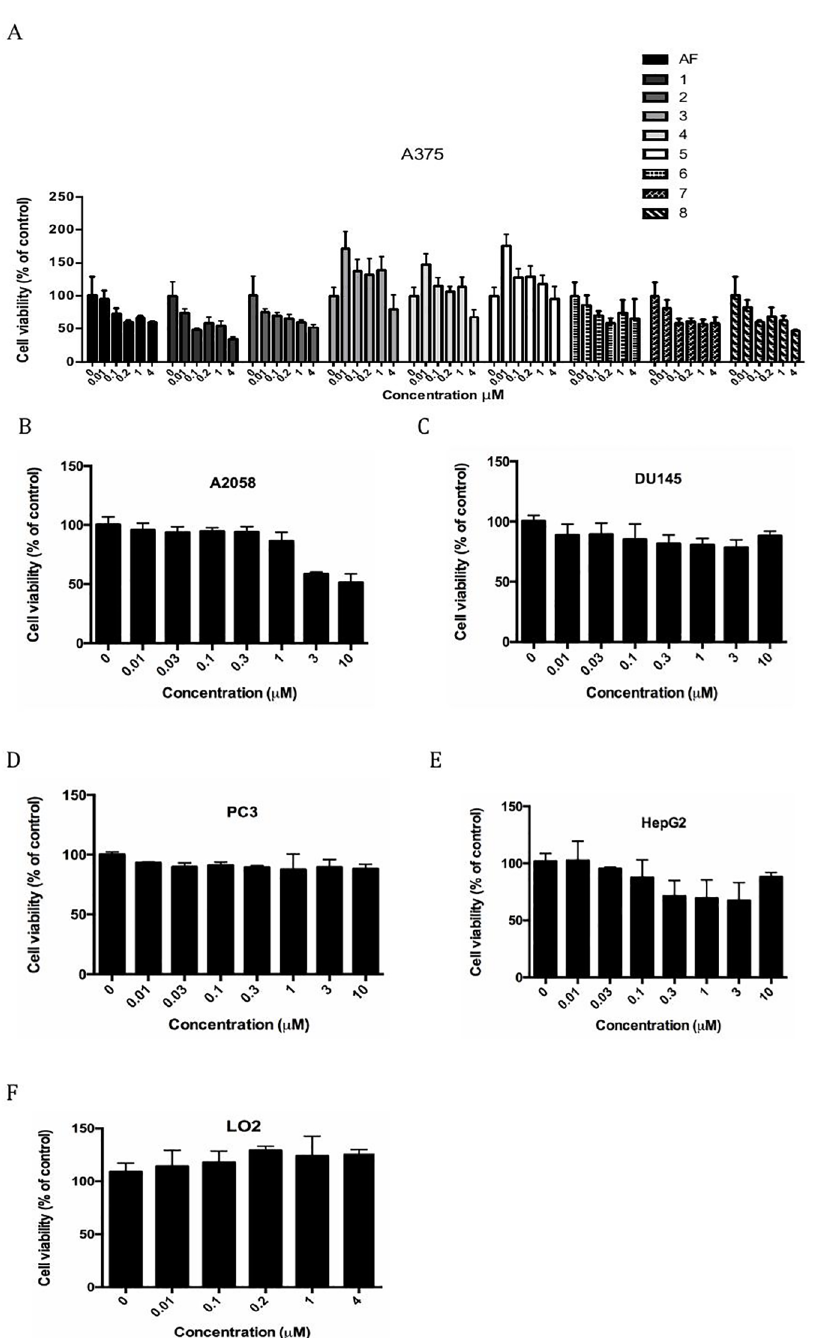
Fig 2. Effects of compounds on cell viability as determined by an MTT assay. A375 cells were treated with 0.01 to 4 μ M of compoundsor amentoflavone for 48 h. LO2 cells were treated with the same concentration of compound 1 for 48 h. PC3, DU145, HepG2 and A2058 cells were treated with 0.01 to 10 μ M of compound 1 for 48 h. Error bars represent the standarddeviationsof results obtainedfrom three independent